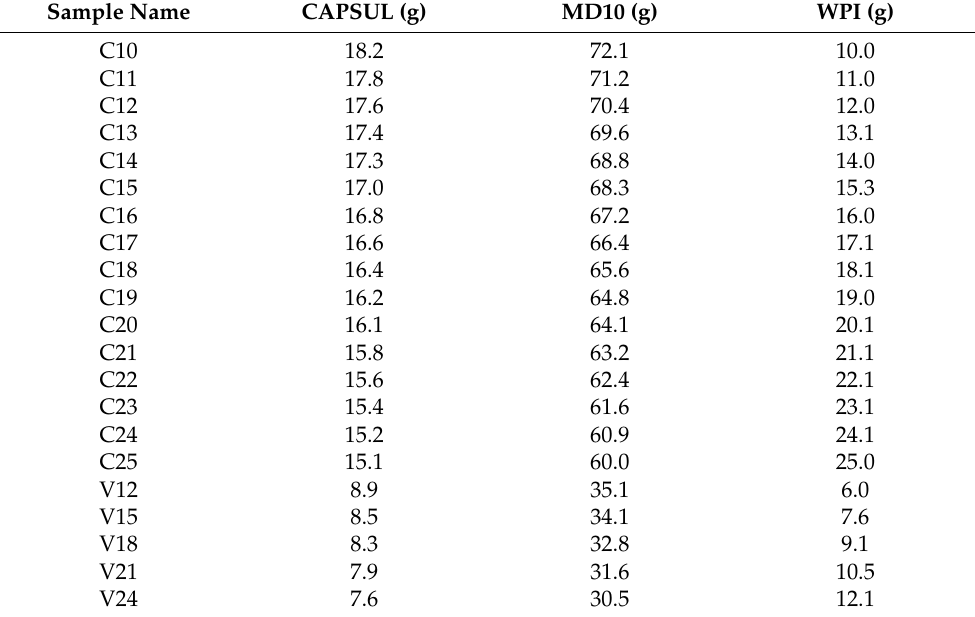
Table 1. Composition of soli mixtures for the preparation of set A